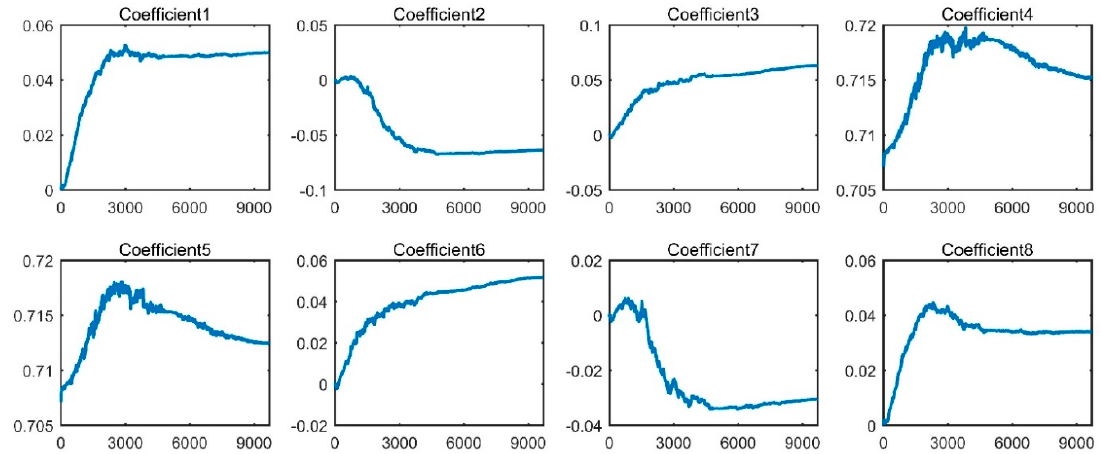
Figure 10. Optimizing process of the wavelet filter coefficients (WFCs) of WPT-CNN-finetuned-db1.